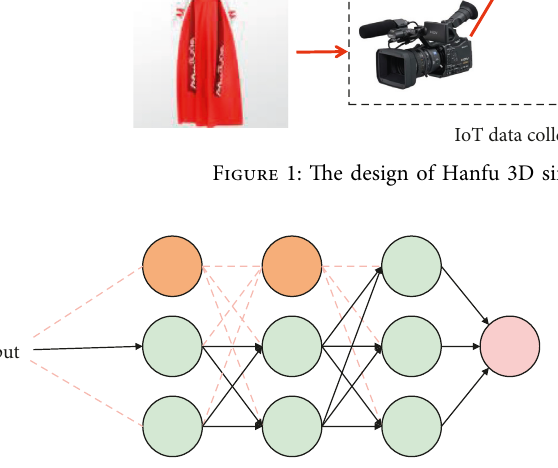
Figure 2: The operational relationship between CNN and